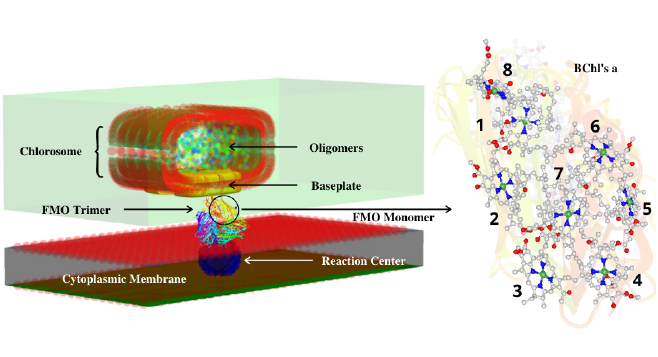
Figure 4. Schematic representation of the spatial arrangement of the Chlorosome, the FMO protein and the reaction center in the cytoplasmic membrane. Light is absorbed by photopigments in the chlorosome and its excitation energy is transferred down to the baseplate which then transfers it to the FMO complex and sequentially to the reaction